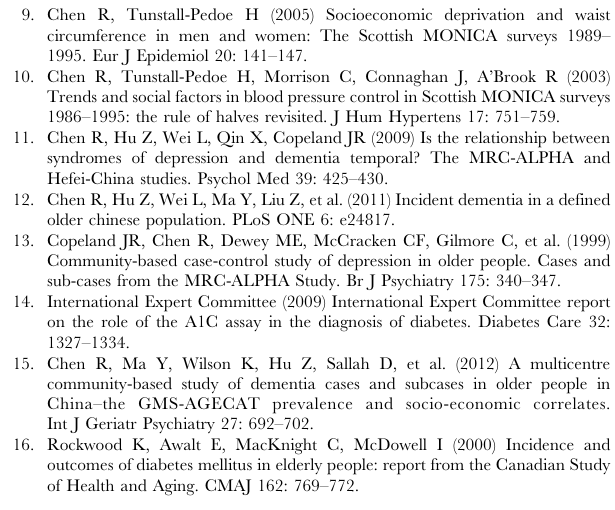
Table S1 Number of incident diabetes and Hazard